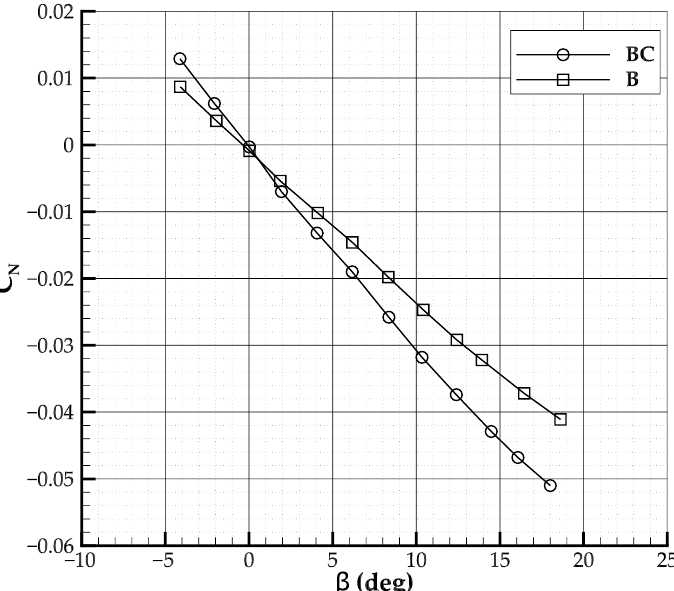
Figure 15. Effect of the canard on the yawing moment coefficient of the fuselage, experimental results. Reference point at x CG = 0, V = 35m/s, Re = 315,000.